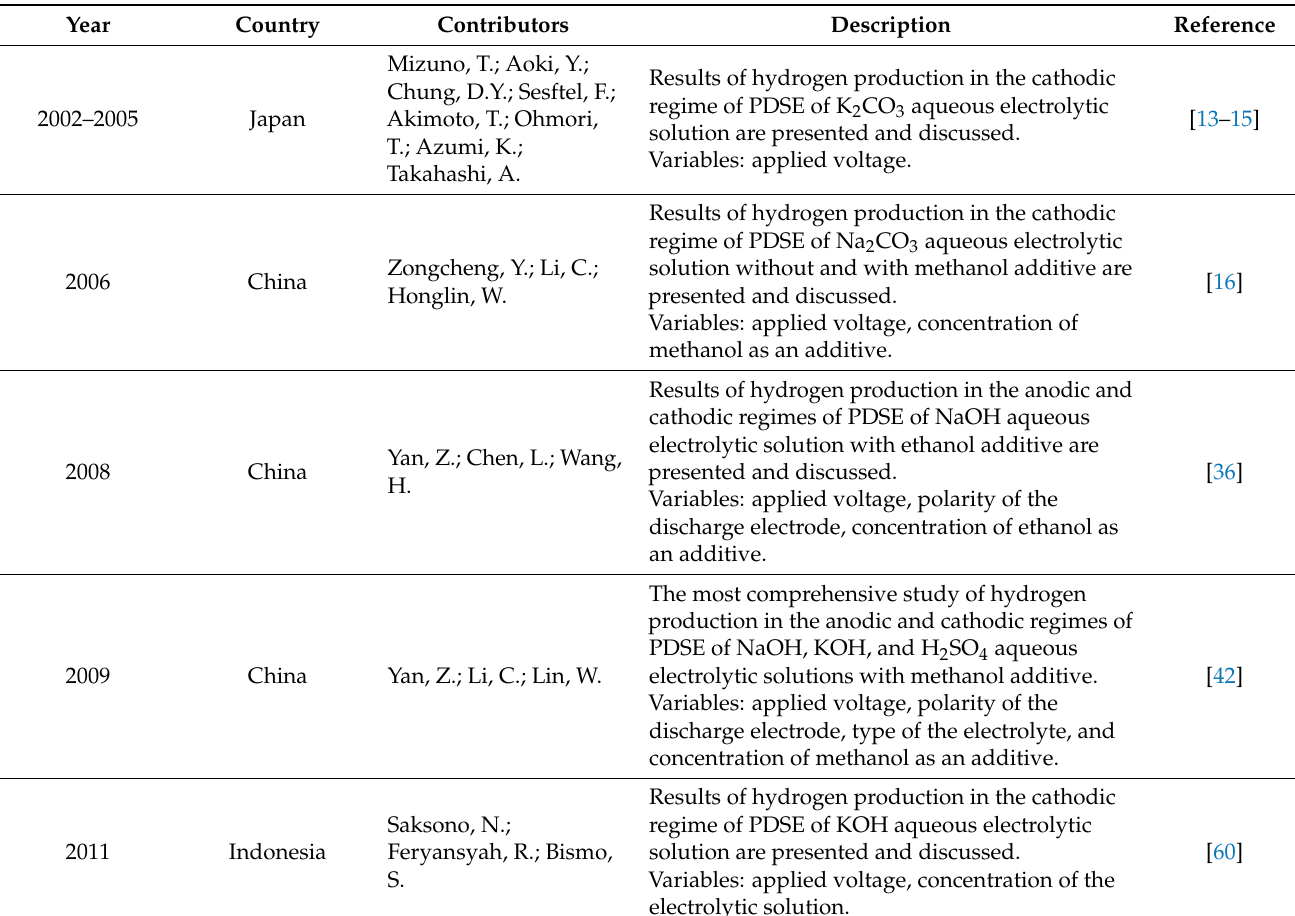
Table 3. Year-wise development of hydrogen production in PDSE of the electrolytic